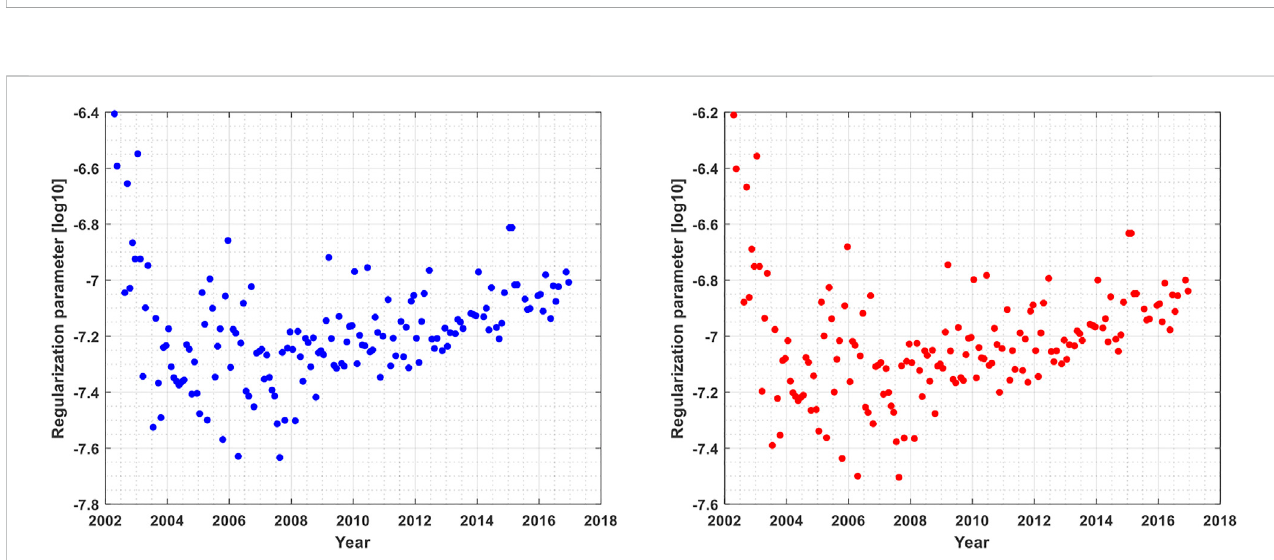
Frontiers in Earth